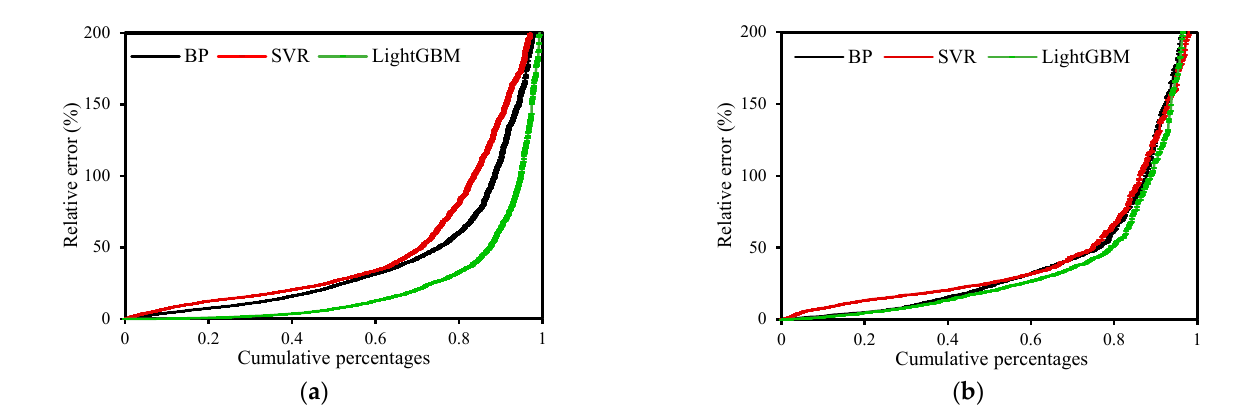
Figure 8. Probability cumulative curve of samples in three models. ( a ) Training set. ( b ) Testing set. To compare the performance of the hourly global solar radiation prediction method proposed in this study, Table 5 summarizes the algorithm structures, inputs, output, and prediction accuracy used in relevant research. The comparison indicates that the predic- tion performance of the method proposed in this study was similar to other models. More- over, the parameters marked in red in Table 5 could not be obtained from the forecast values, while the input parameters of our study can be easily obtained and the data pre- processing is simple. Table 5. Comparison of the performance of the models in this study.